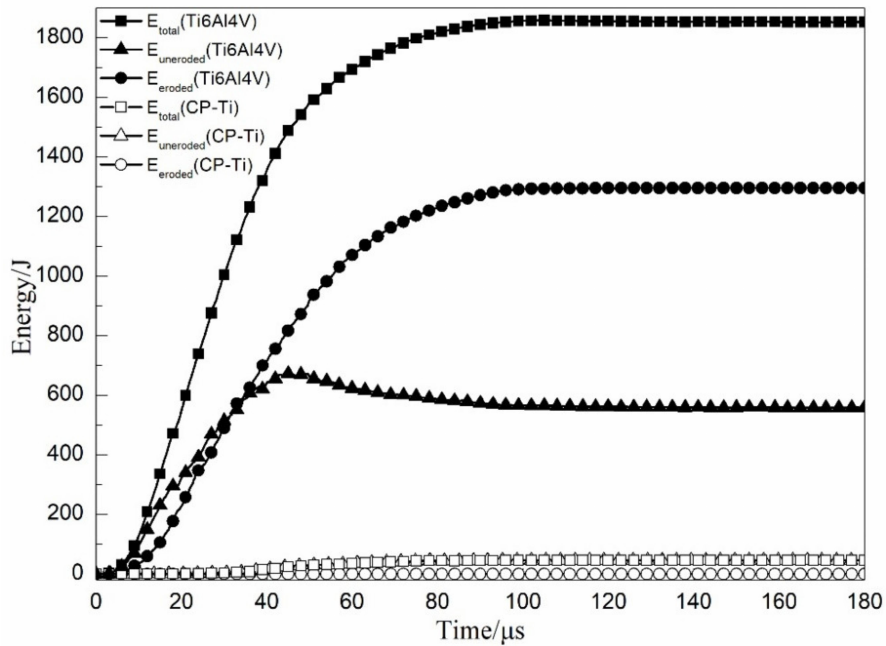
Figure 7. Energy absorption history curve of Ti6Al4V and CP-Ti subjected to the penetration process of Ti64 /